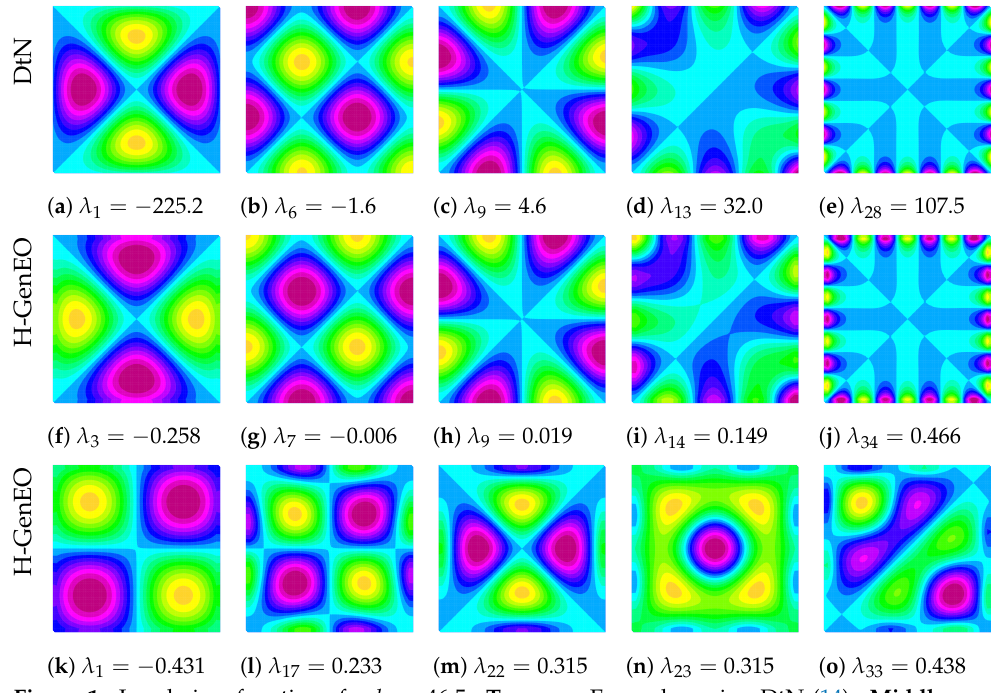
Figure 1. Local eigenfunctions for k = 46.5. Top row: Examples using DtN (14). Middle row: Equivalent examples using H-GenEO (19). Bottom row: Examples using H-GenEO which are not found amongst the DtN eigenfunctions.